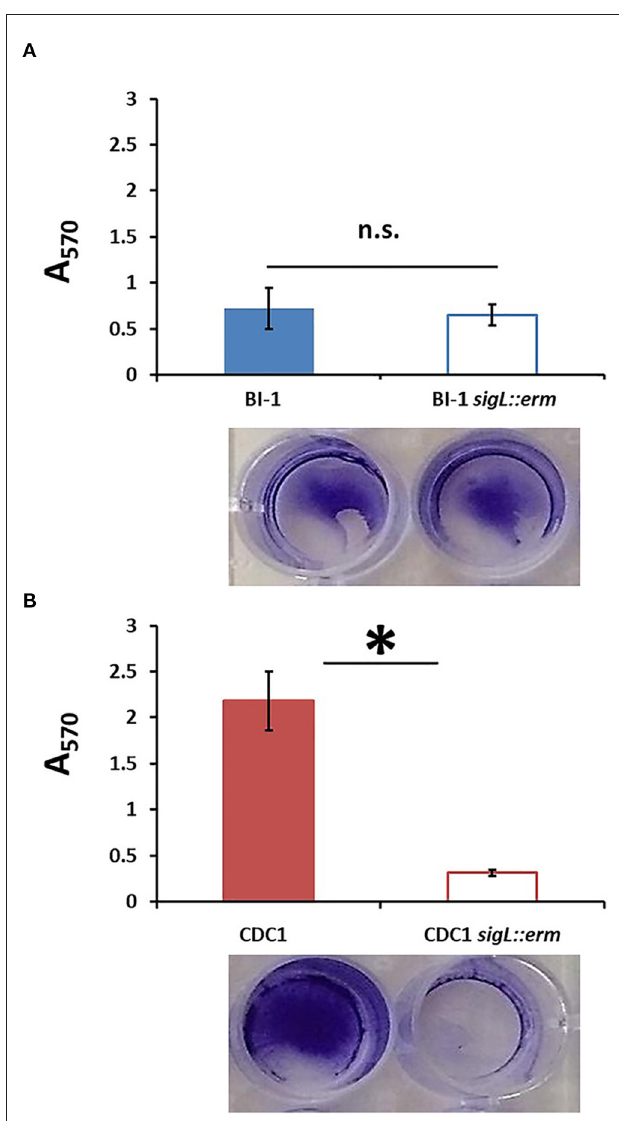
FIGURE 6 | Biofilm formation is reduced in CDC1 sigL::erm , but not in BI-1 sigL::erm . Biofilm was quantified by the release of crystal violet retained by the C. difficile biomass after 72h. Absorbance was measured at 570nm. (A) Biofilm formation in BI-1 and BI-1 sigL::erm . (B) Biofilm formation in CDC1 and CDC1 sigL::erm . Samples were grown in biological triplicate and compared using Student’s t -test. * p < 0.05.